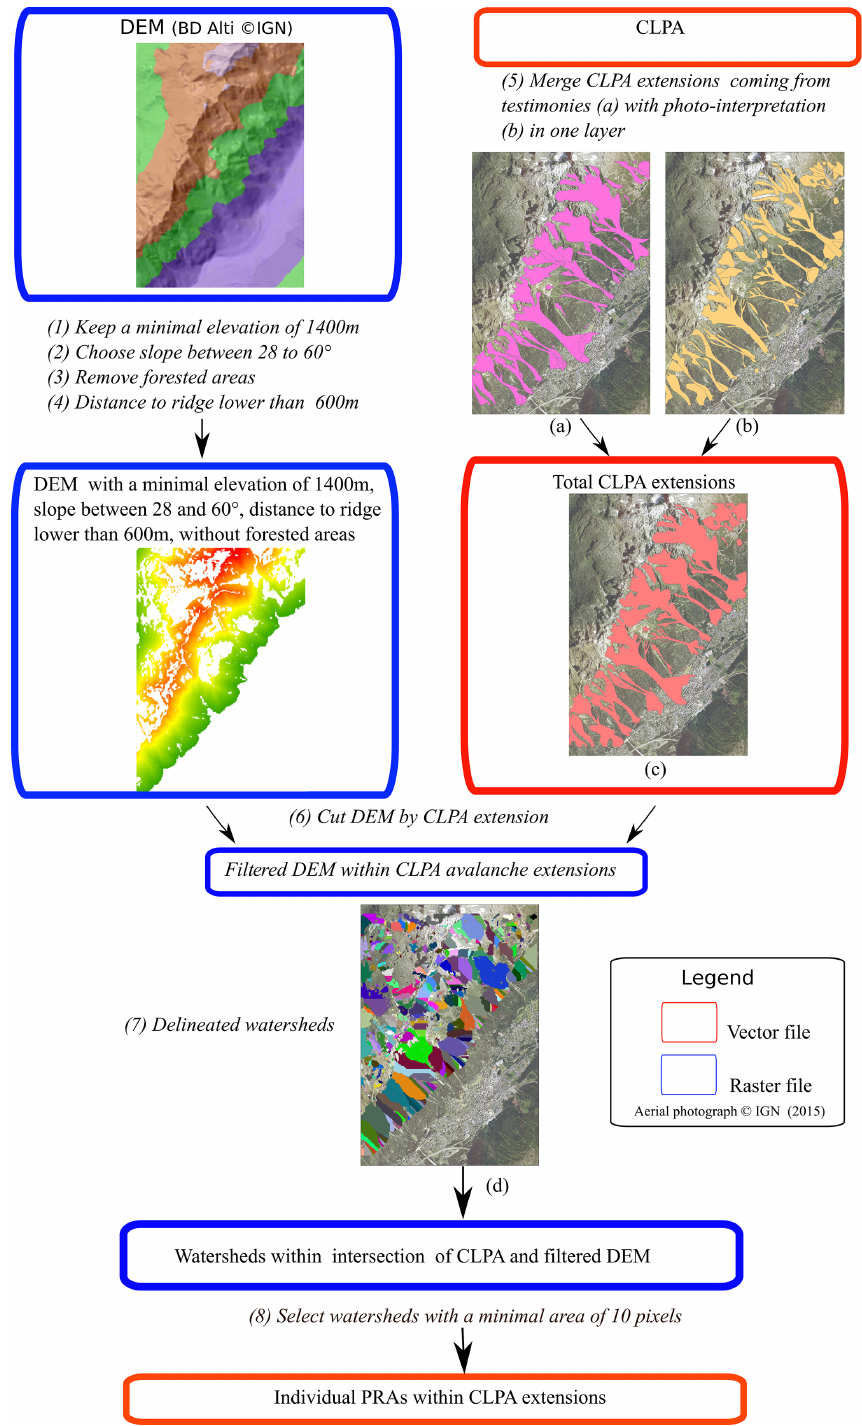
Figure 4. The French avalanche cadastre (CLPA) and the processing steps used to identify individual PRAs within CLPA avalanche extents (“avalanche extensions”) as a validation sample for the proposed PRA detection method. (a) CLPA avalanche extents from testimonies, (b) CLPA avalanche extents from photo-interpretation, (c) union of CLPA avalanche extents and (d) delineation of individual PRAs within CLPA avalanche extents. Aerial photograph © IGN